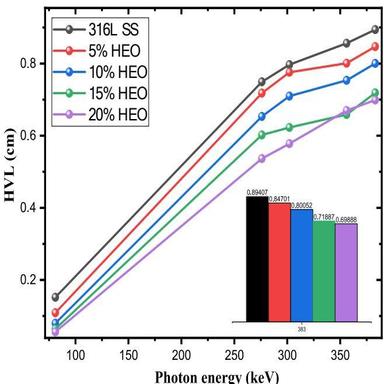
Variation of half value layer (HVL) against photon energy for the HEO samples.